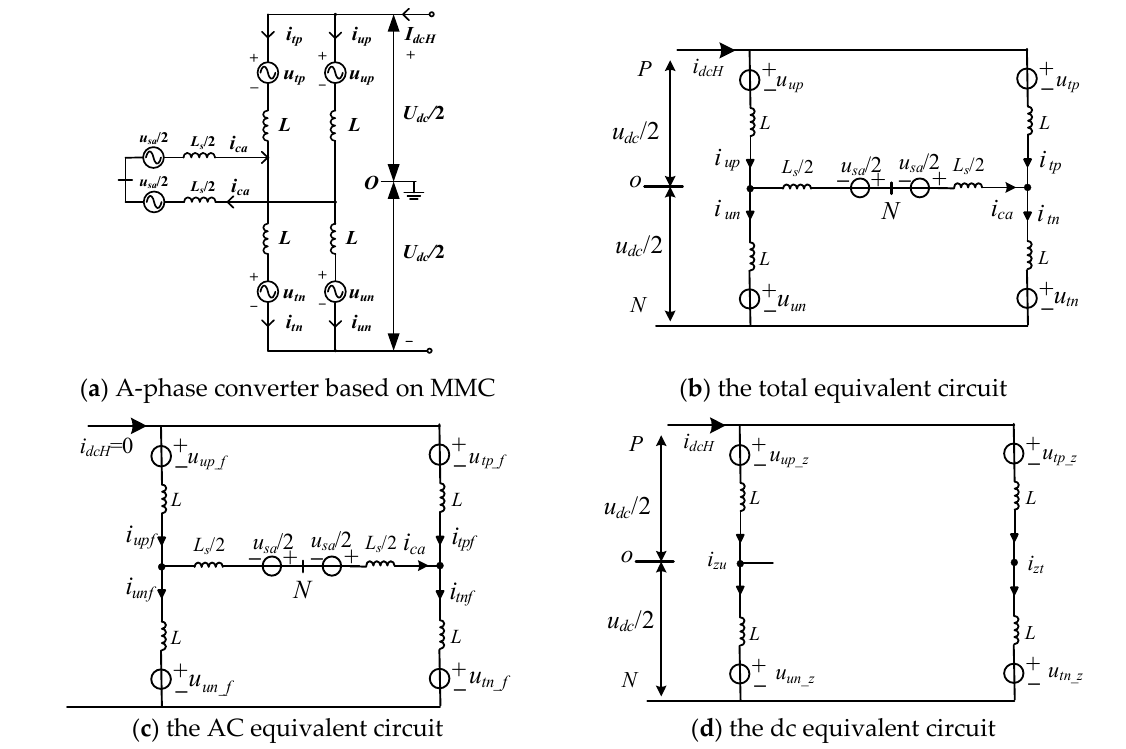
Figure 2. The A-phase equivalent circuit of the full-bridge-based MMC. In order to maintain the balance between the DC voltage, the neutral point N or the midpoint O of MMC’s dc-link is grounded [40], and if the system is in the symmetric op- eration,: (cid:1847) (cid:3041)(cid:3016) ≈ 0 . According to the ac and dc equivalent circuits of the system shown as Figure 2c,d, the voltage and current can be obtained